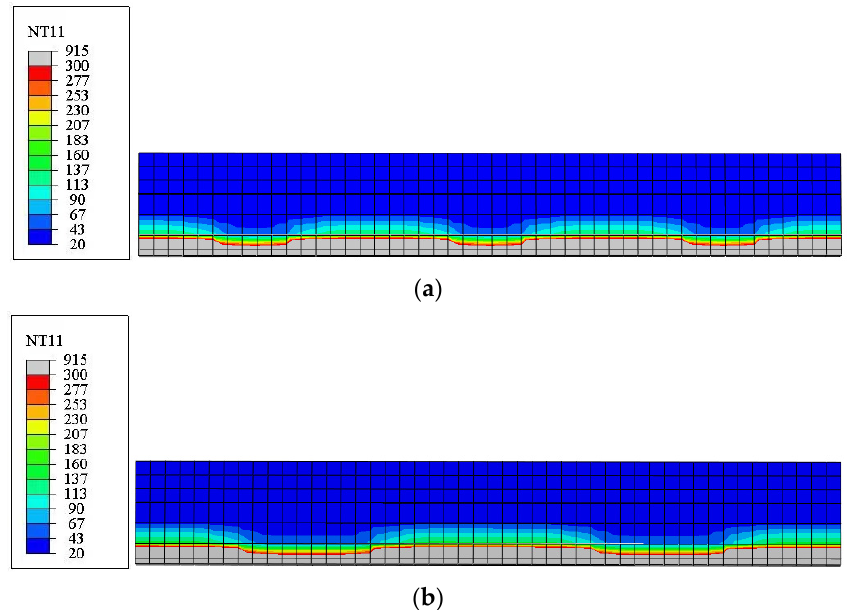
Figure 15. The cross section of temperature distributions: ( a ) TCG2; and ( b ) TCG3.